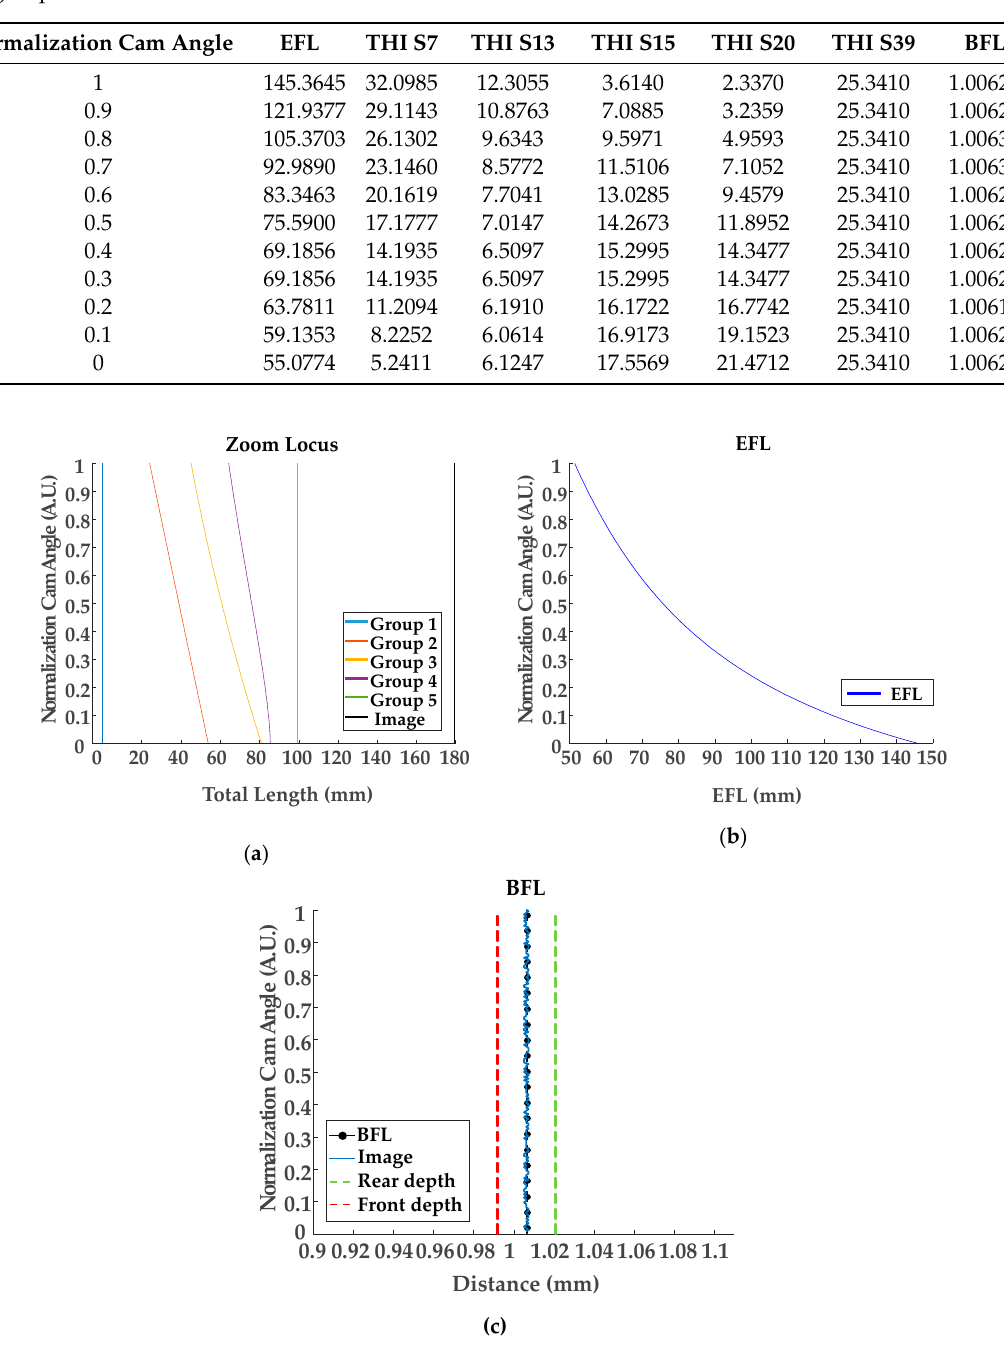
Table 11. Results of reapplying the Pad é approximation after correcting BFL by moving the fourth lens group from the results in Table 10.